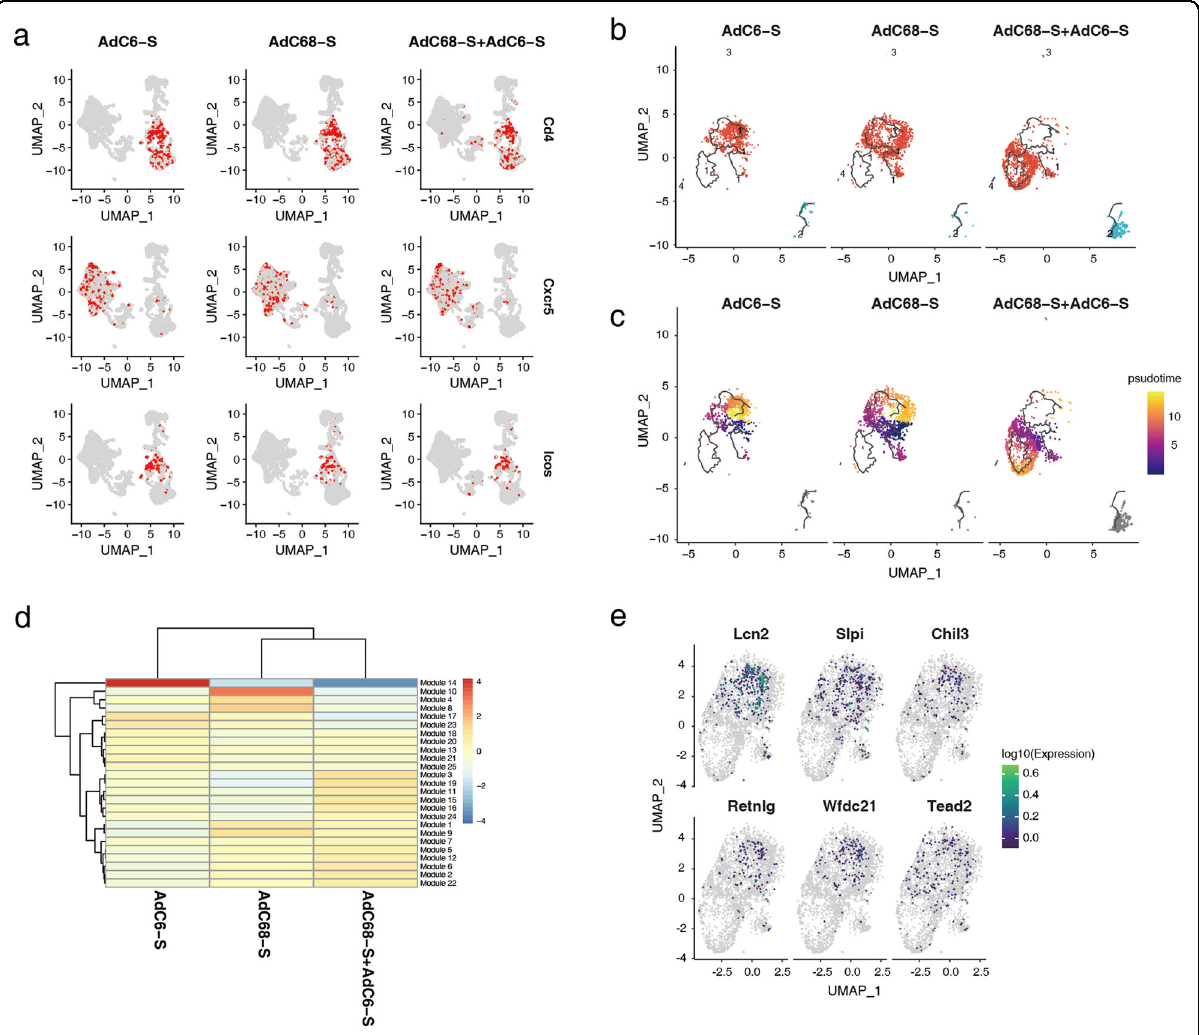
Fig. 5 Heterologous prime-boost strategy of vaccine candidates promoting differentiation of follicular B cells through scRNA-seq analysis. a UMAP of Tfh cells in each vaccinated group, and expression levels of representative marker genes of Tfh cells are plotted. The color key from gray to red indicates relative expression levels from low to high, respectively. b Reconstruction of the developmental trajectory of follicular B cells using the Monocle 3 algorithm, and four subgroups were identi fi ed. Each cell is colored by its subgroup category and displayed on UMAP. c UMAP of single- cell pseudotime trajectory of follicular B cells; cells are ordered in pseudotime and colored in a gradient from purple to yellow. d Heatmap displaying modules of co-regulated genes in subgroup 1 for follicular B cells. e UMAP of DEGs in module 10 and module